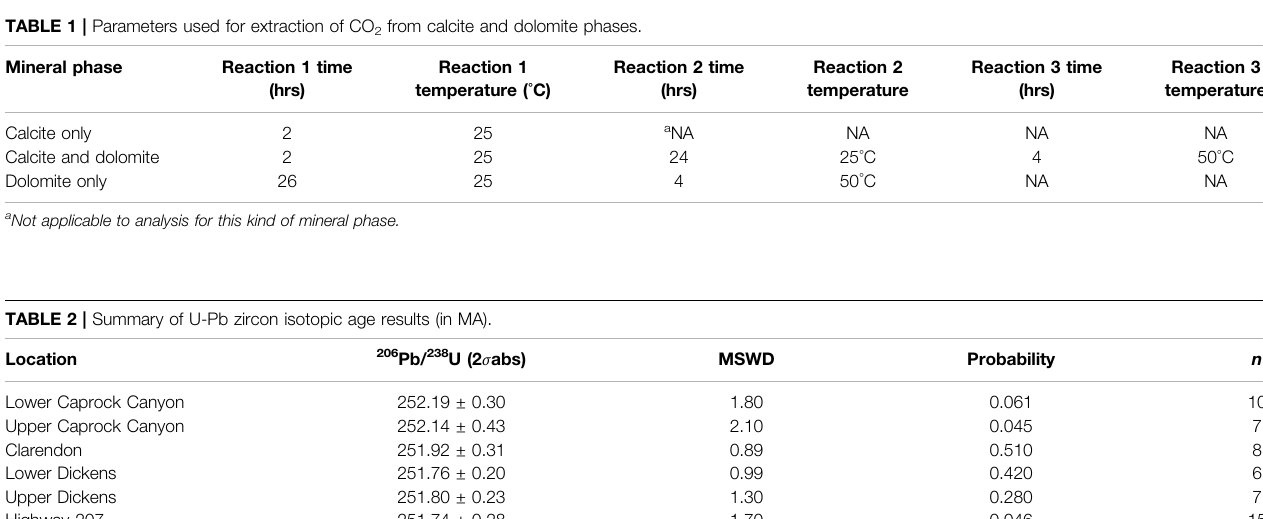
Frontiers in Earth Science |